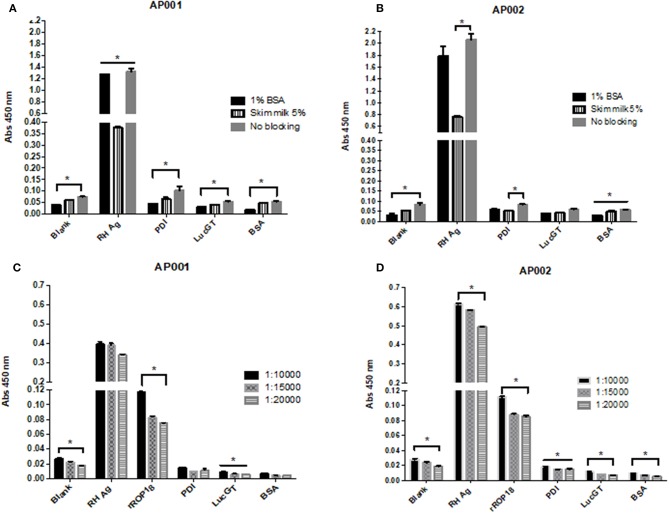
Evaluation of different blocking conditions and streptavidin dilutions for AP001 (A,C) and AP002 (B,D) ELAA test. Different blocking conditions were evaluated: 1% bovine serum albumin, 5% skim milk and no blocking (A,B). Three different dilutions of streptavidin (1: 10,000, 1: 15,000 and 1: 20,000) were evaluated (C,D). RH Ag was used as a positive control (50 μg/ml) for both experiments. rROP18 (25 μg/ml) was also used as positive control for streptavidin experiment. Three negative controls were included, PDI, LucGT, and BSA. The data are represented by the mean ± SEM. Kruskal Wallis. *p < 0.05.